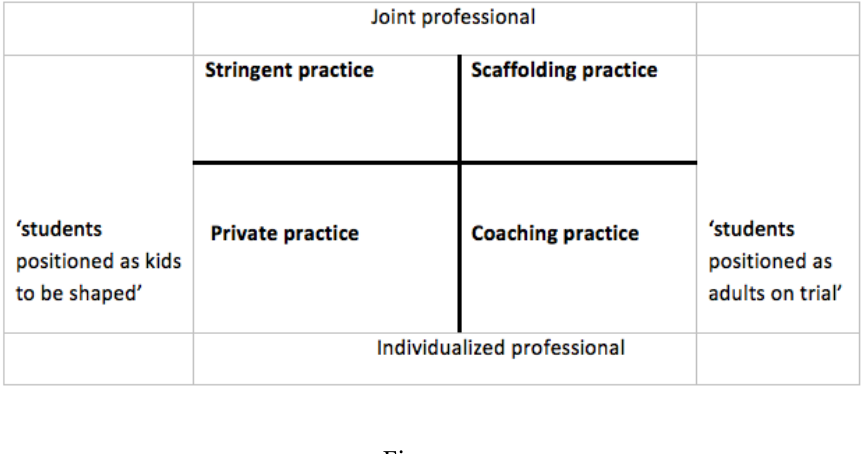
Possible learning